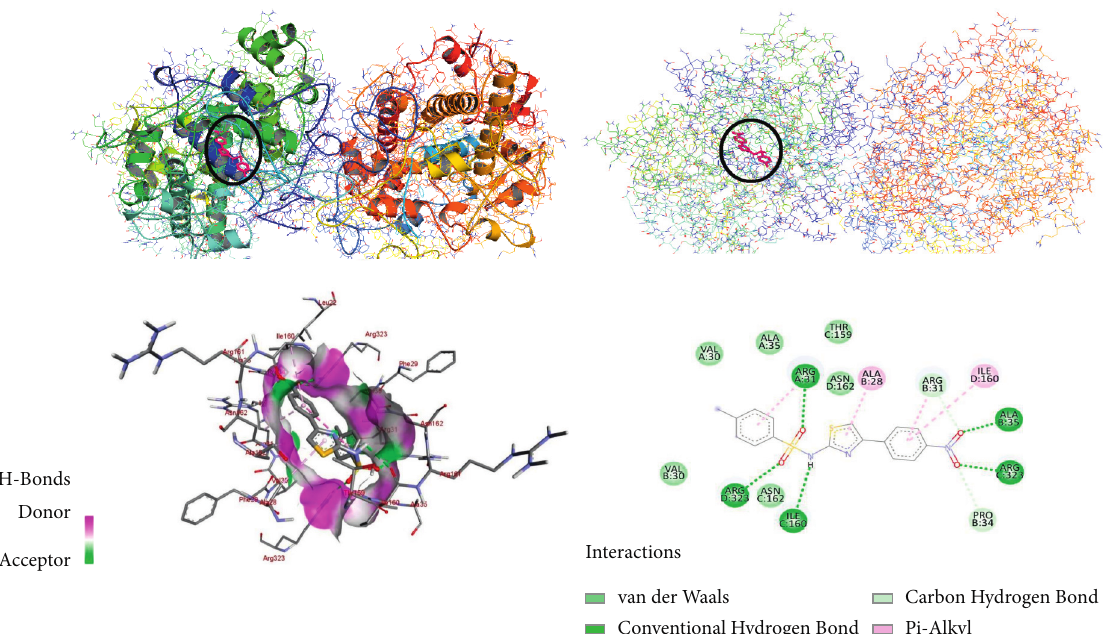
Figure 5: The 2D and 3D binding interactions of compound 11a against human myeloperoxidase (PDB ID: 1DNU). 3D ribbon and line models show the binding pocket structure of human myeloperoxidase with compound 11a . Hydrogen bonds between compounds and amino acids are shown as green dashed lines, and hydrophobic interactions are shown as pink lines.